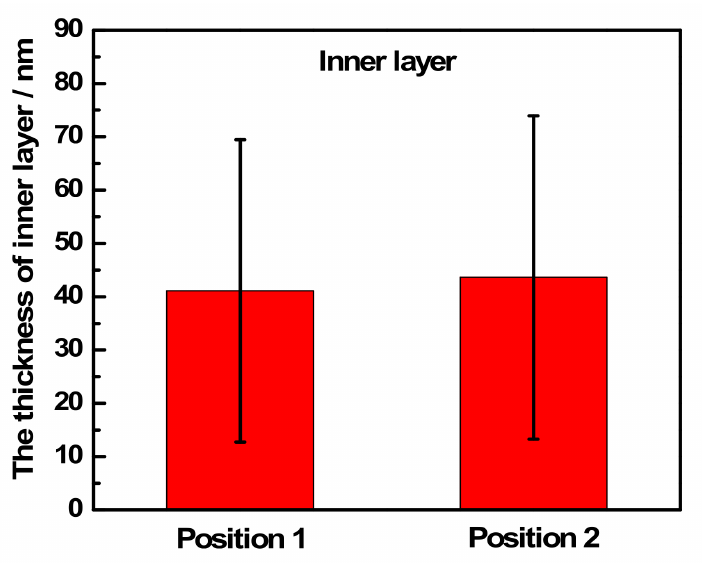
Figure 9. The average thickness of the inner layer of fouling at different positions of the SG tube measured according to Figure 7a,b, and the error bar indicates the standard